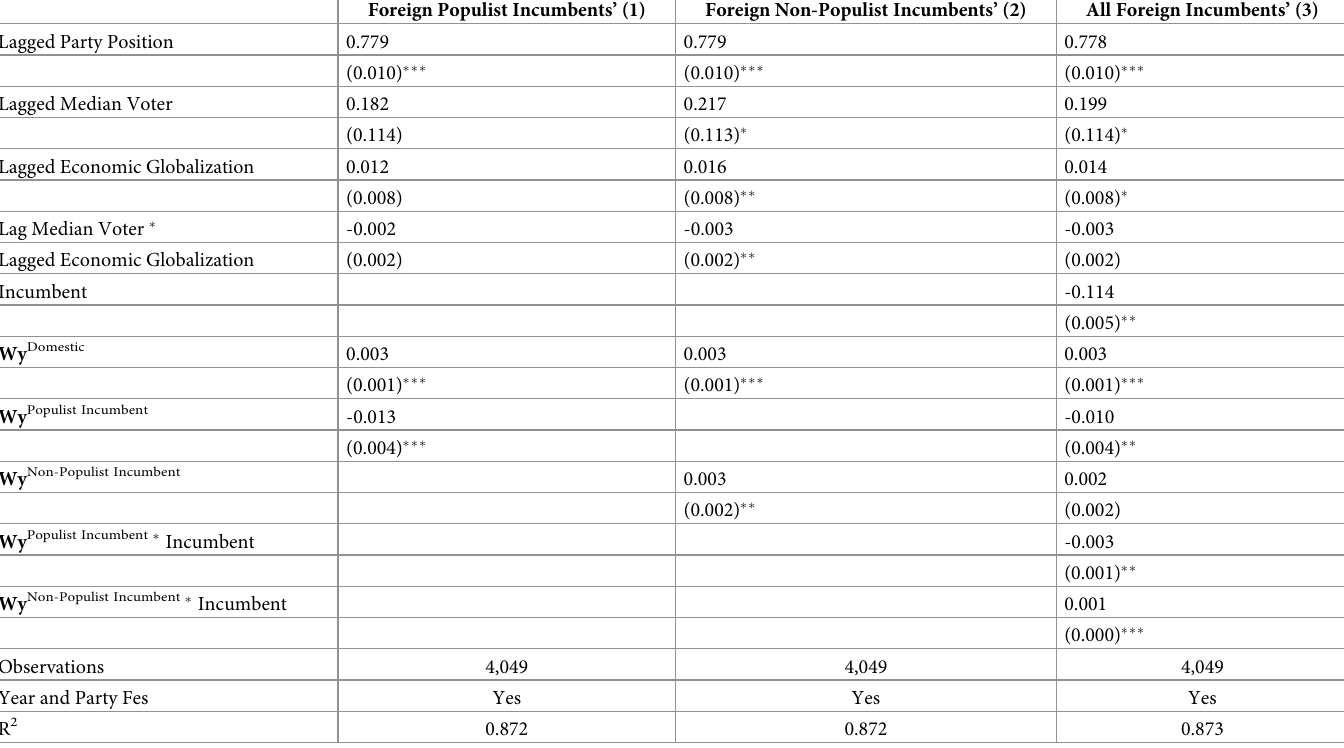
Table 1. Party policy diffusion–Populist backlash.